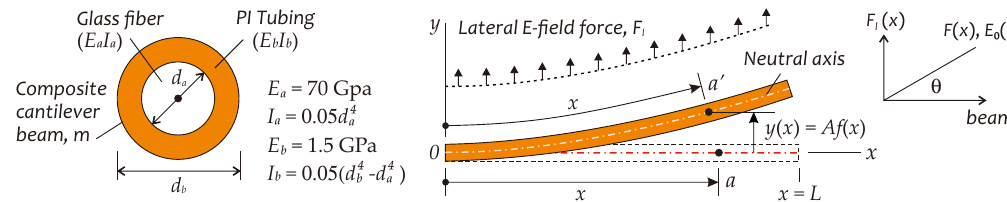
Figure 3. A structure schematic of composite cantilever beam adopted in E -field